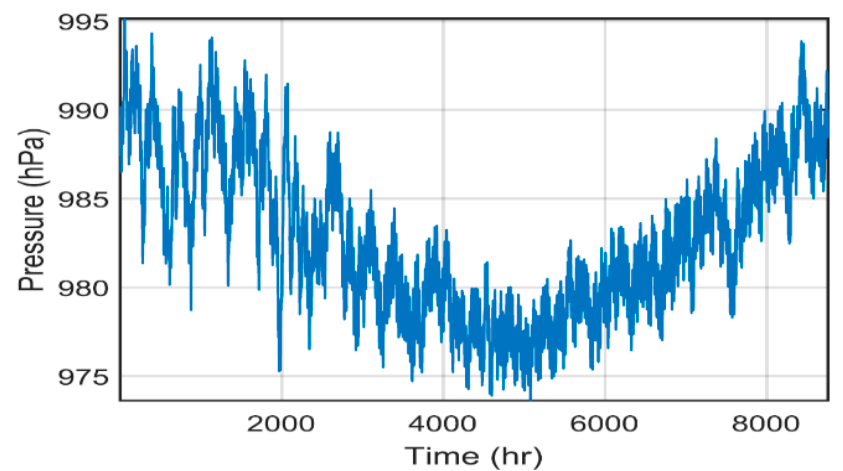
Figure 9. Atmospheric pressure variation in Aswan.